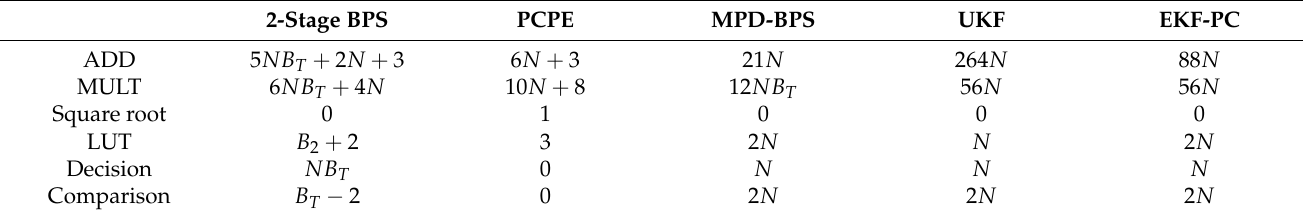
Table 1. Computational Complexity of CPR